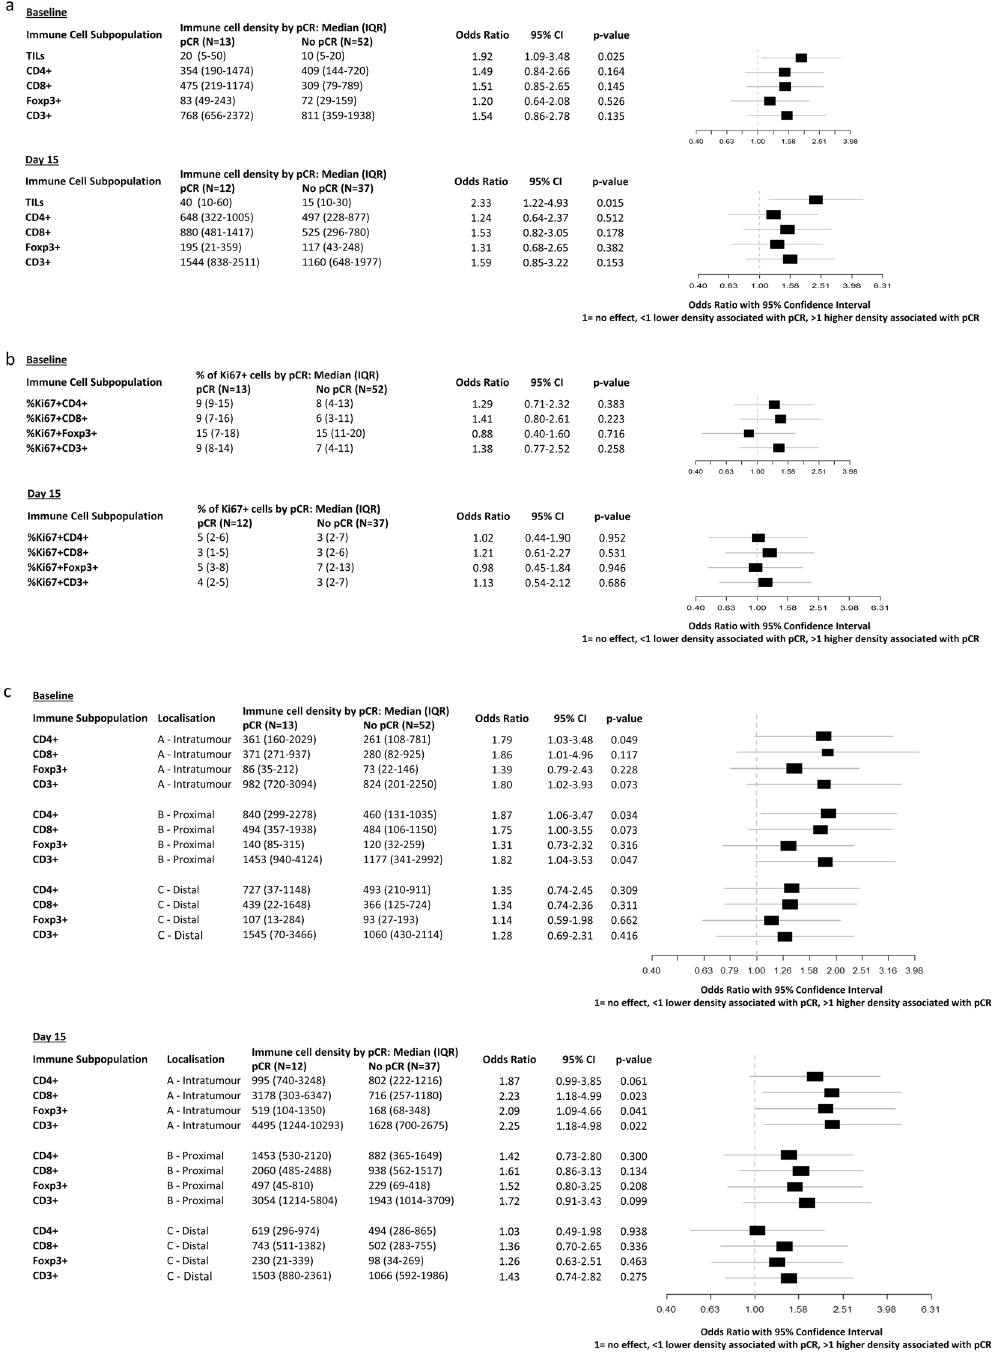
Fig. 5 Immune cell density and pathological complete response. a Odds ratios (95% con fi dence interval) for pathologic complete response (pCR) for 10% increases in TIL levels and 1000 cells/mm 2 increases in immune cell density evaluated on baseline and Day 15 (on-treatment) samples. b Odds ratios (95% con fi dence interval) for pathologic complete response (pCR) for increases in % of proliferating immune cells for each immune cell subpopulation evaluated on baseline and day 15 (on-treatment) samples. c Odds ratios (95% con fi dence interval) for pathologic complete response (pCR) for 1000 cells/mm 2 increases in immune cell density according to immune cell localisation evaluated on baseline and day 15 (on-treatment)